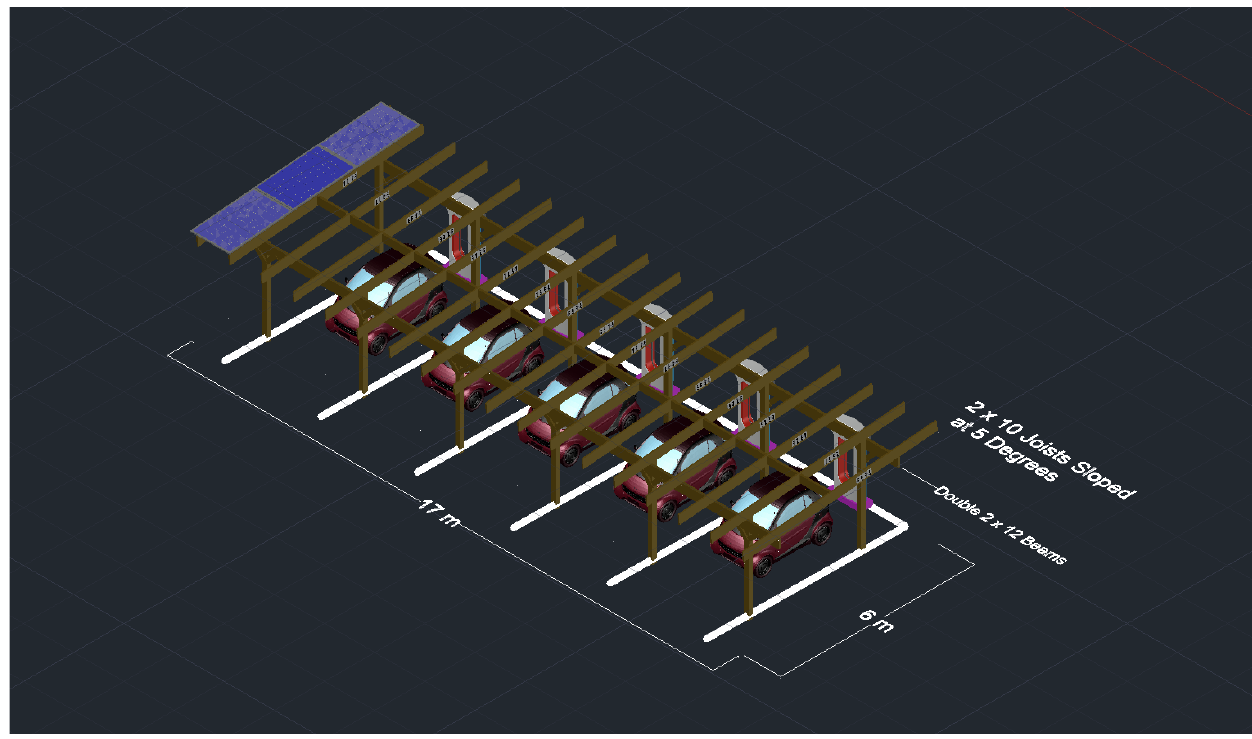
Figure 6. Finished Single-Span System.